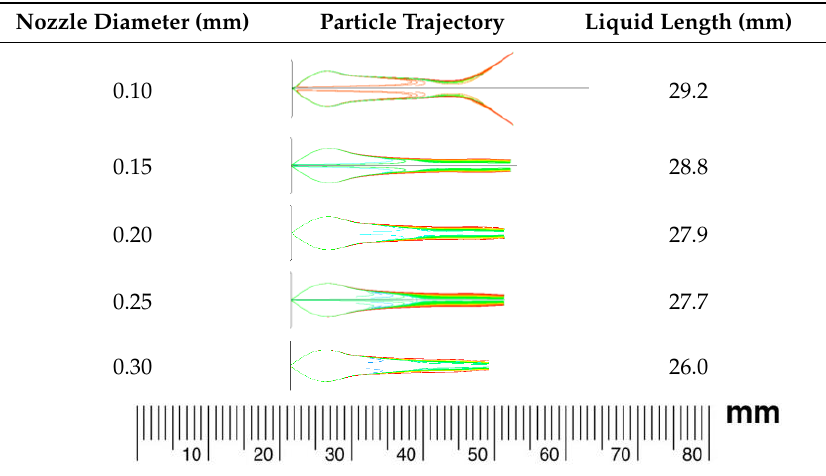
Table 4. Liquid penetration track and liquid length versus different injecting nozzle diameters.